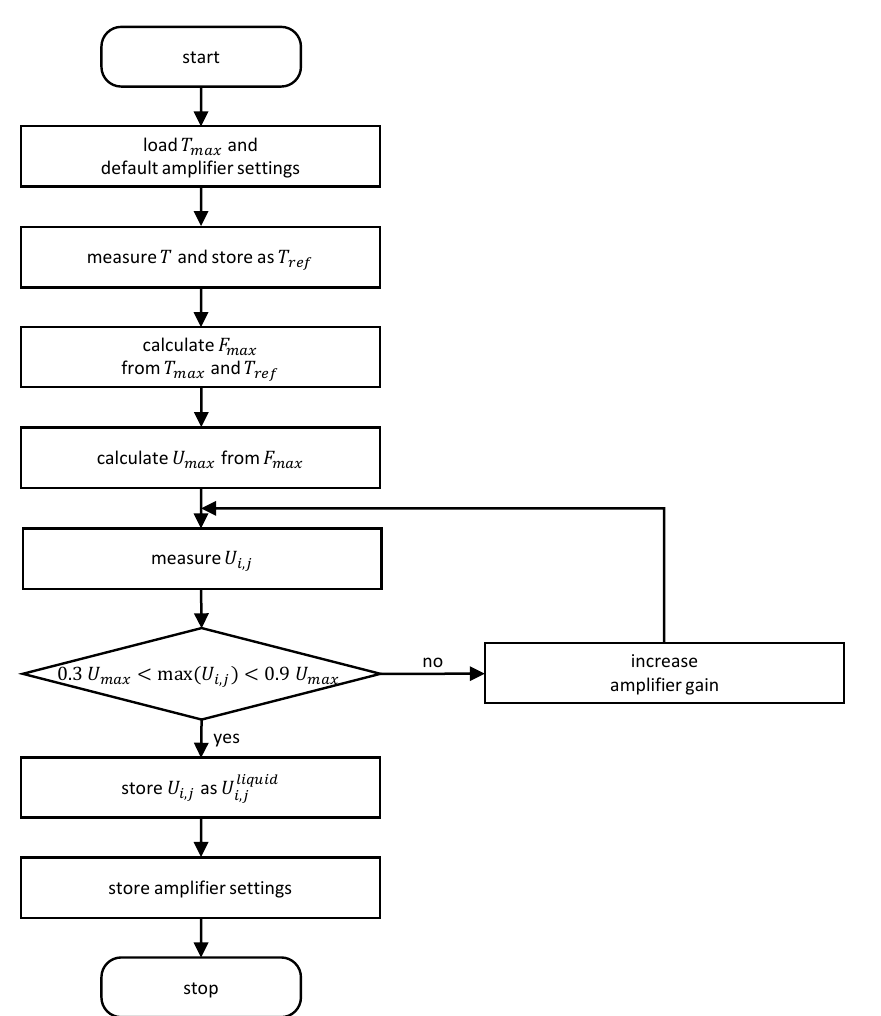
Figure 4. Flow chart for autonomous adjustment of amplifier gains and acquisition of the reference data